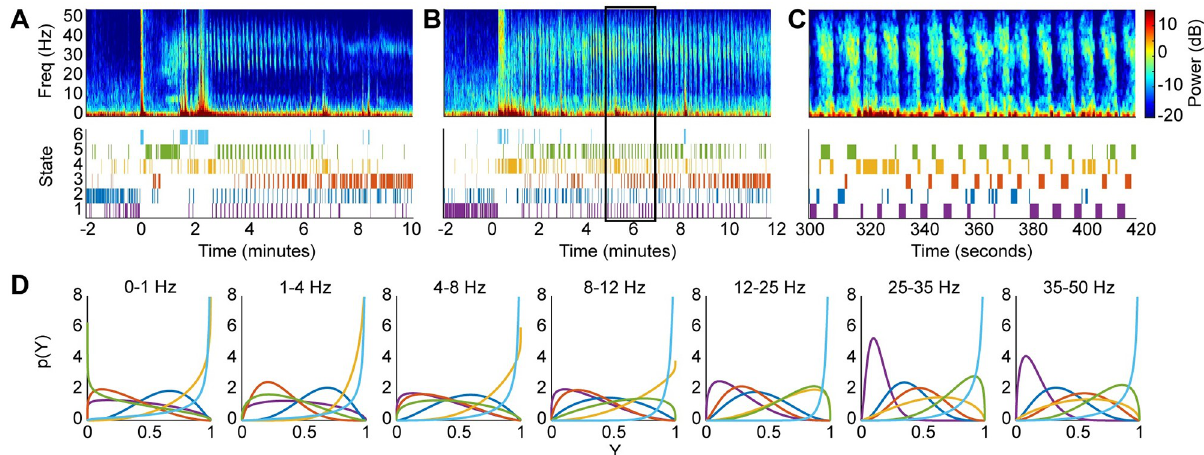
Fig 6. The 6-state beta-HMM can be fit across independent EEG recordings from multiple human subjects to create a typical human-specific model. (A-B) Multitaper spectrograms of EEG and corresponding estimated latent state trajectories from 2 of the 9 human subjects. (C) Enlarged view of a typical 120s epoch indicated by the rectangular portion in panel B. (D) Frequency band-specific beta pdfs for each of the 6 states estimated from the 9 EEG sessions (Y—scaled power). Each color corresponds to a state, as denoted in the state trajectories in panels